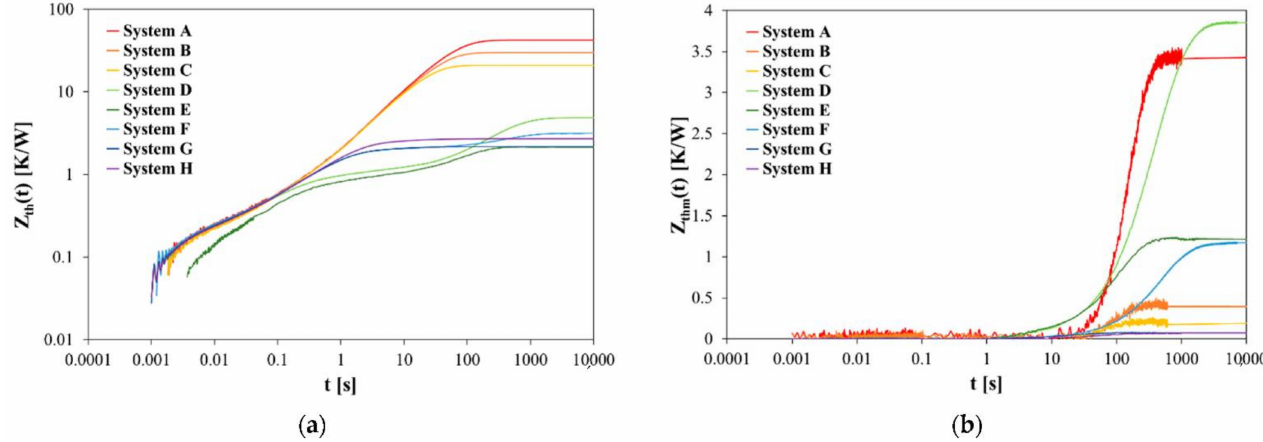
Figure 10. The ( a ) self- and ( b ) transfer-transient thermal impedances of the investigated MOSFETs with all the cooling